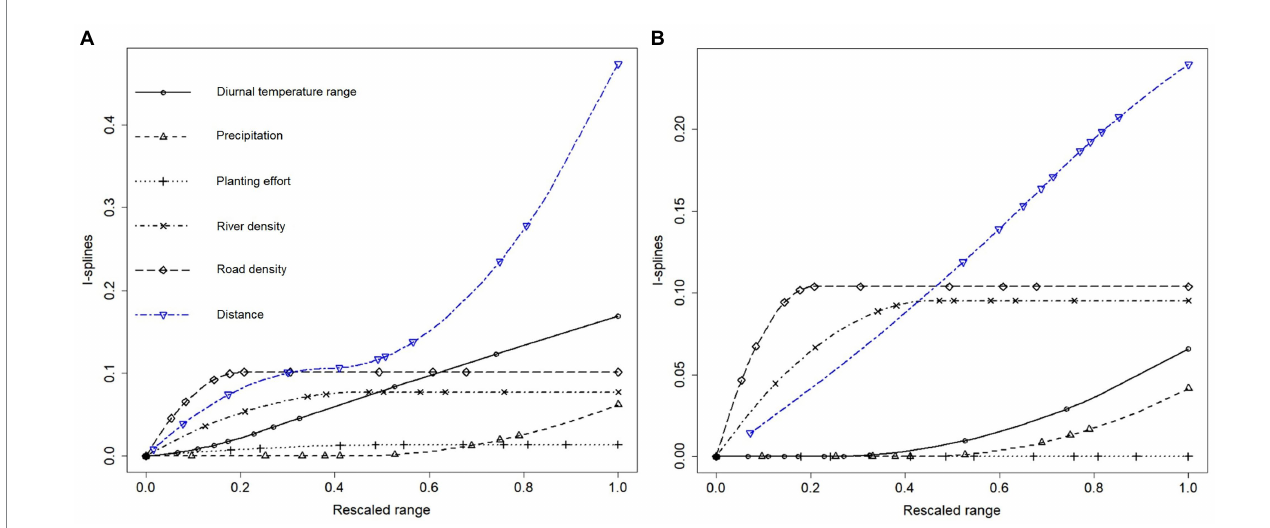
FIGURE 4 (A) I-spline regression of narrow-ranged species (zeta order two) and (B) widespread species (zeta order five) naturalised trees and shrubs, for which the magnitude of an I-spline is interpreted as the total contribution of the predictor to compositional turnover (i.e., the opposite to compositional zeta similarity). Following the convention of dissimilarity modelling, the vertical axis of I-splines represents compositional dissimilarity or turnover, which is opposite to zeta similarity. Notably, distance is consistently a strong predictor at all ranges, but with low road density being more important than distance for turnover of widespread species. The steepness of the response curve at a particular value for a predictor represents the contribution of the predictor to compositional turnover at this value. For instance, river density contributes more to compositional turnover in low-drainage areas (a steeper response curve for river density < 0.3) than in high-drainage areas (a flatter response curve for river density > 0.5). Each variable is rescaled to a value between minimum and maximum, with markers separating 10th percentiles. Distance is rescaled between zero and maximum and thus the minimum distance between sites (the leftmost marker) is above zero.